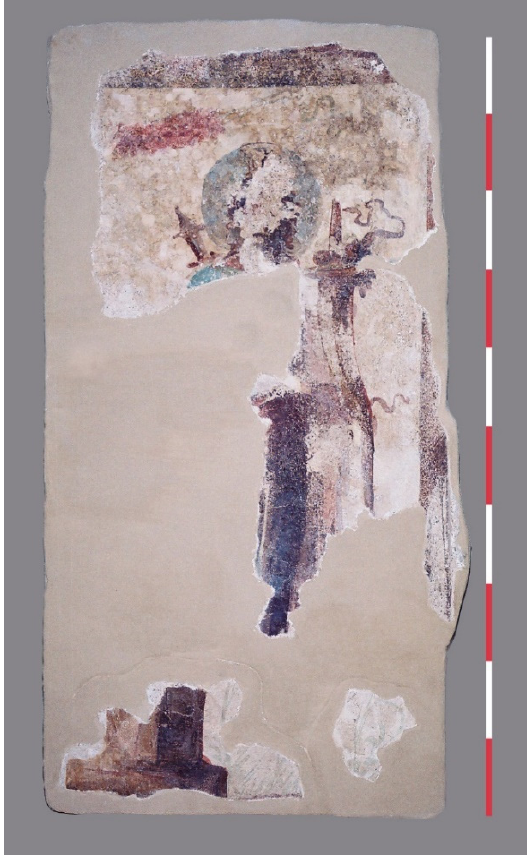
Figure 15. House H10, painting depicting Heron (photo Stanis ł aw Medeksza).